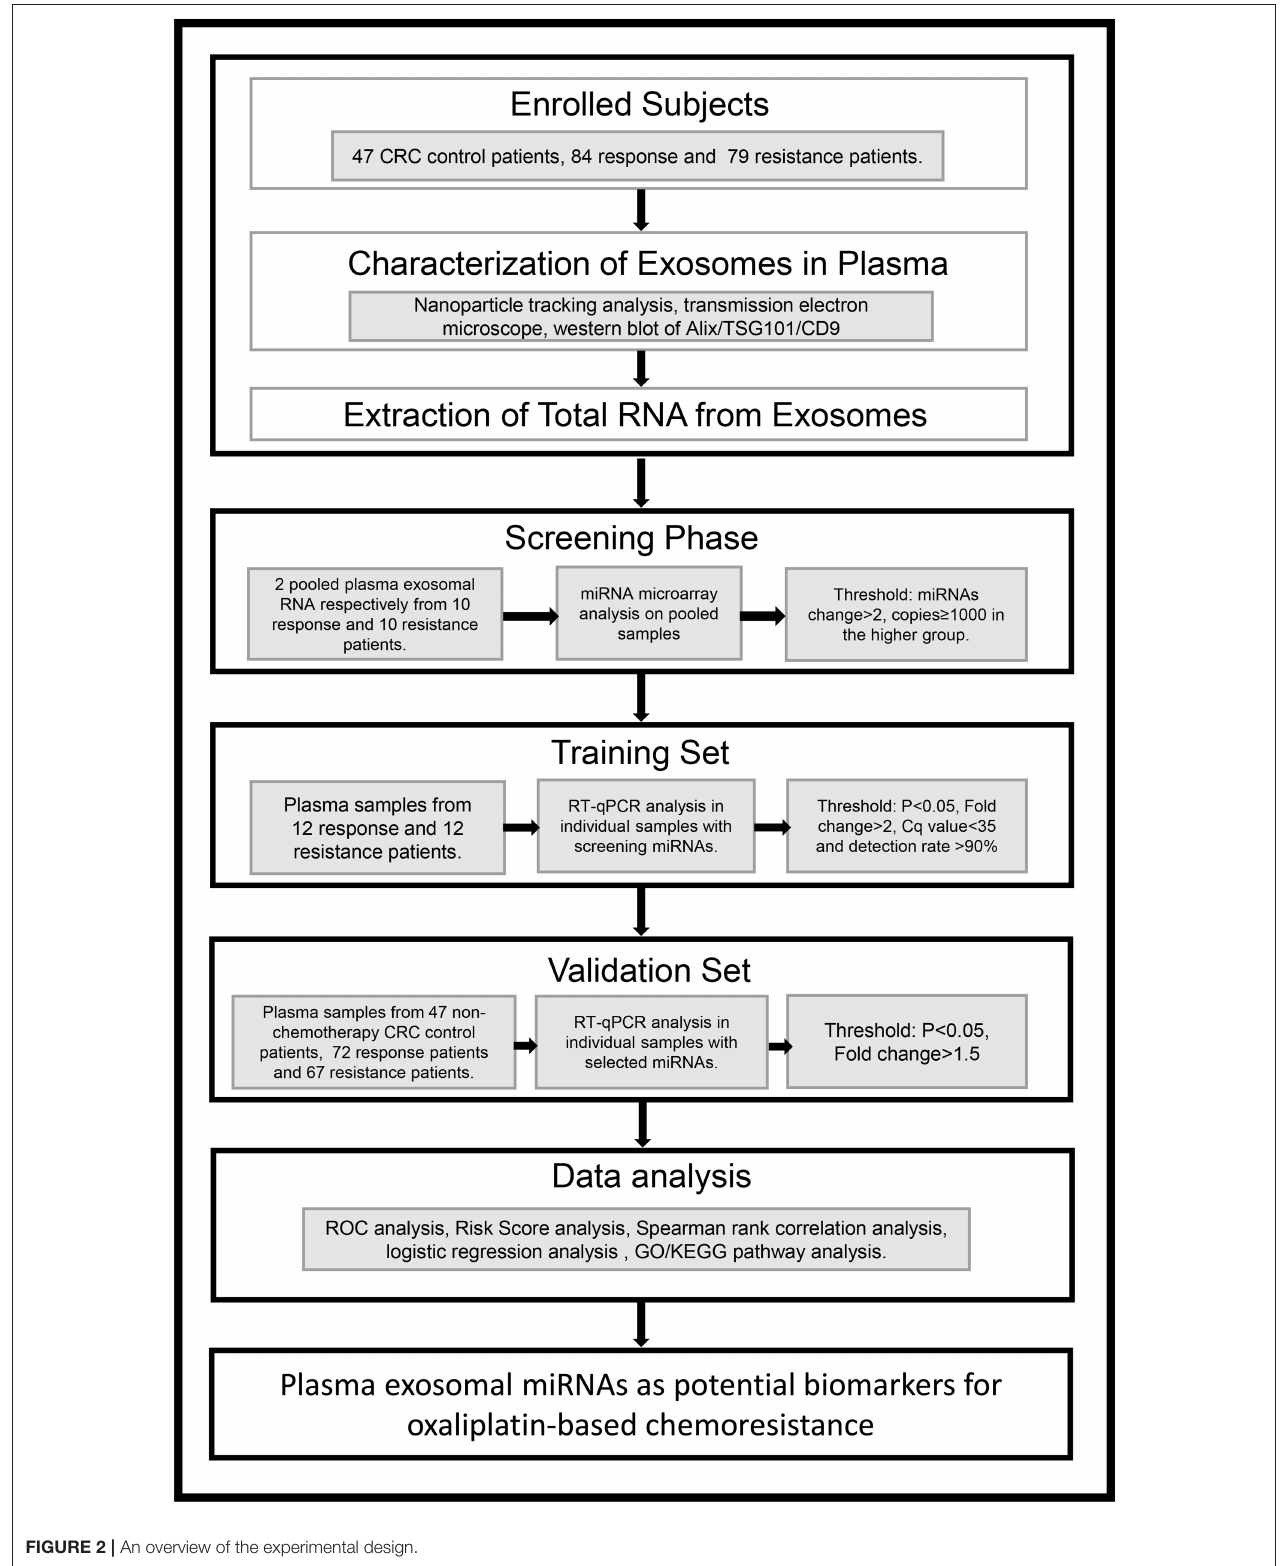
FIGURE 2 | An overview of the experimental design.